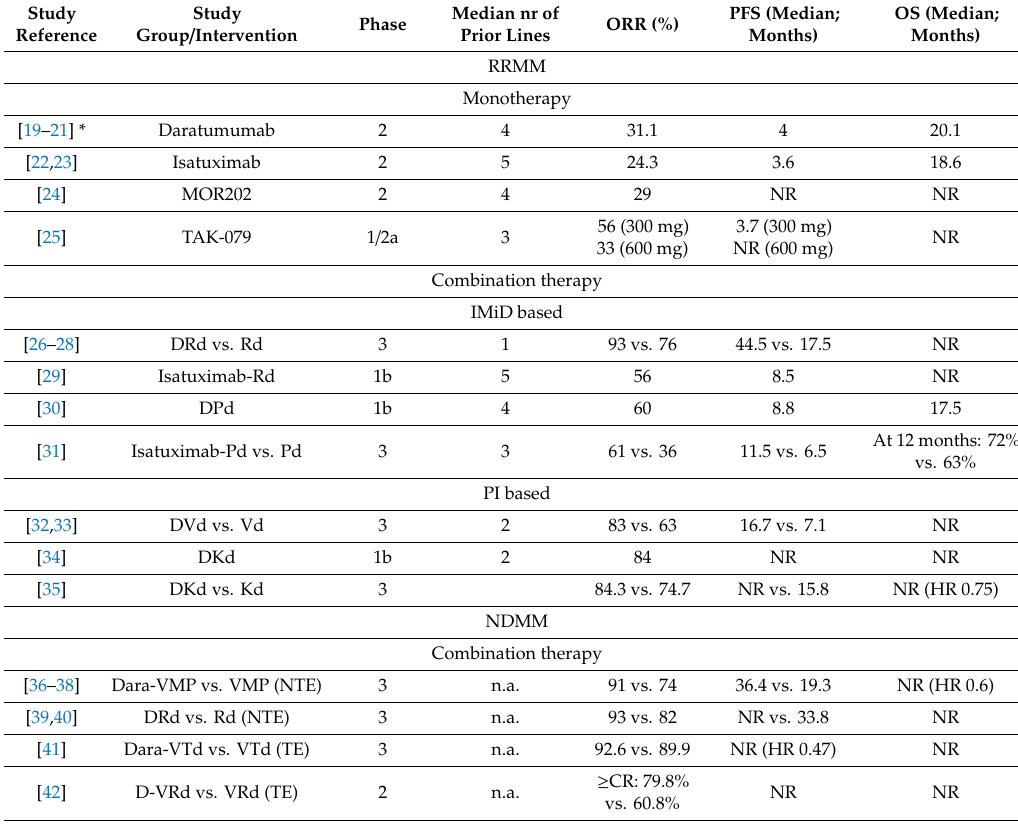
* Data from the pooled analysis (21) of both trials (19, 20) are shown. Abbreviations: ORR: overall response rate; PFS: progression-free survival; OS: overall survival; RRMM: relapsed / refractory multiple myeloma; IMiD: immunomodulatory drugs; DRd: daratumumab-lenalidomide-dexamethasone; DPd: daratumumab-pomalidomide-dexamethasone; PI: proteasome inhibitor; DVd: daratumumab-bortezomib-dexamethasone; DKd: daratumumab-carfilzomib-dexamethasone; NDMM: newly-diagnosed multiple myeloma; VMP: bortezomib-melphalan-prednisone; NTE: non-transplant eligible; VTd: bortezomib- thalidomide-dexamethasone; TE: transplant eligible; D-VRd: daratumumab-